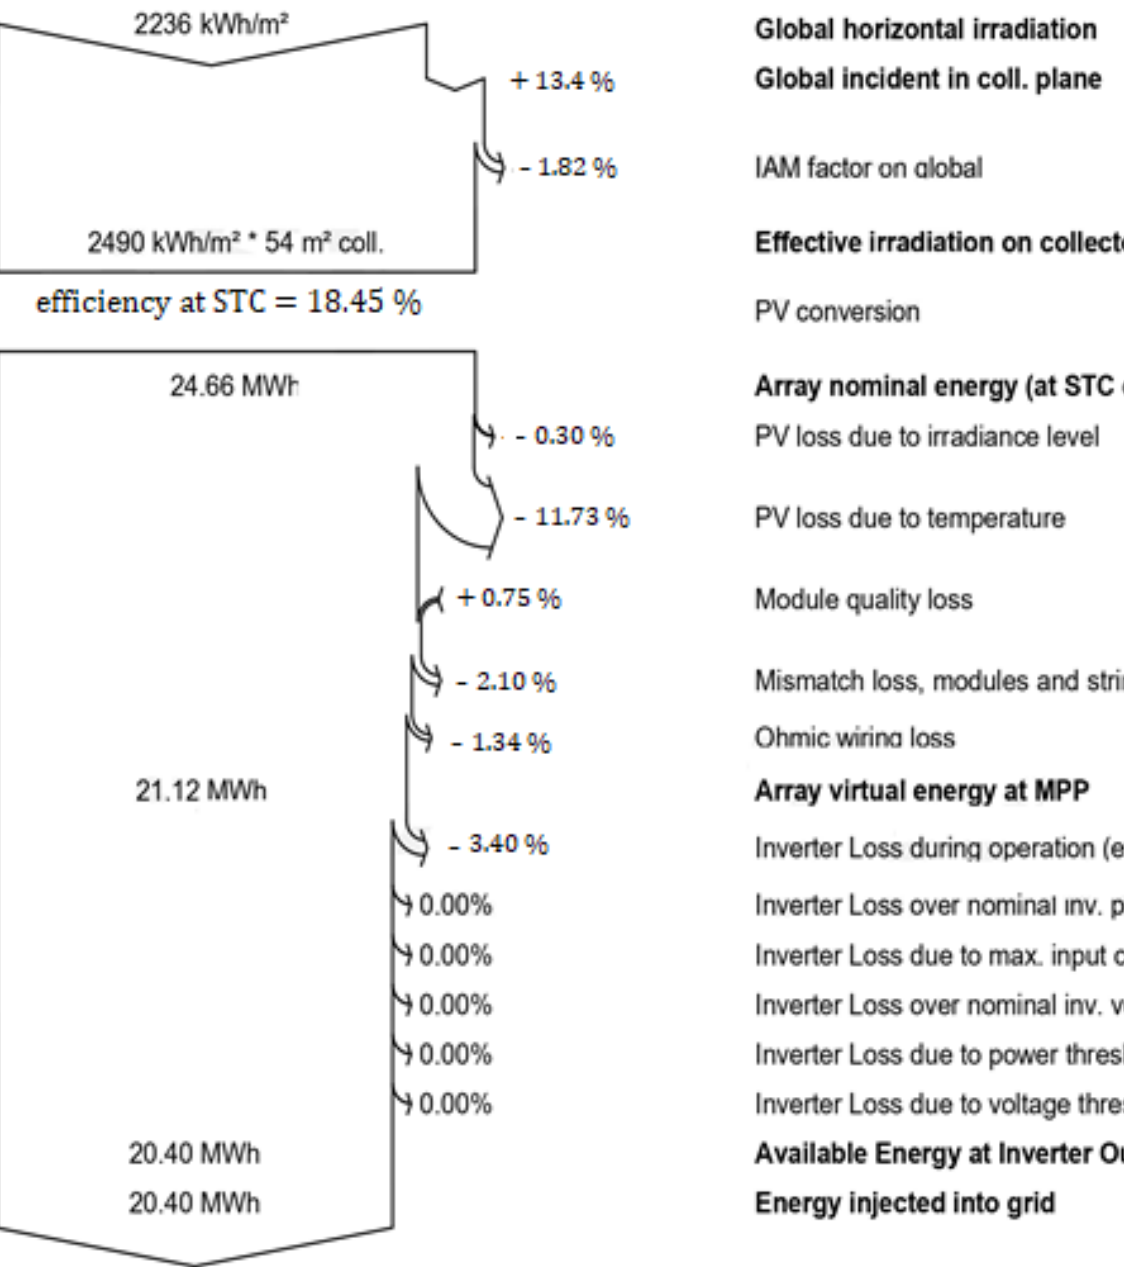
Figure 10. Loss diagram for the Darab area. Additionally, for each area, there are other different losses to consider. For example, the PV loss during the irradiance level for the Darab is − 0.30%, and for the Meybod, it is − 0.29%. The PV loss due to temperature is − 11.73% for the Darab and − 12.09%